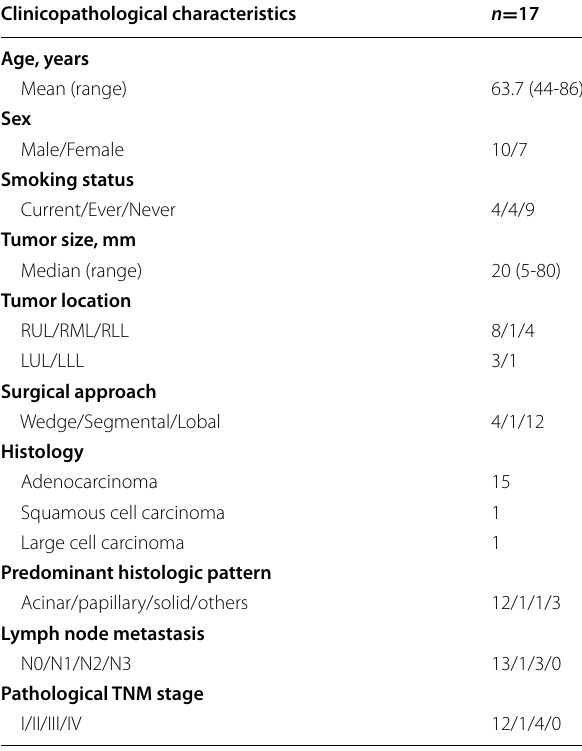
Table 1 Clinicopathological characteristics of enrolled